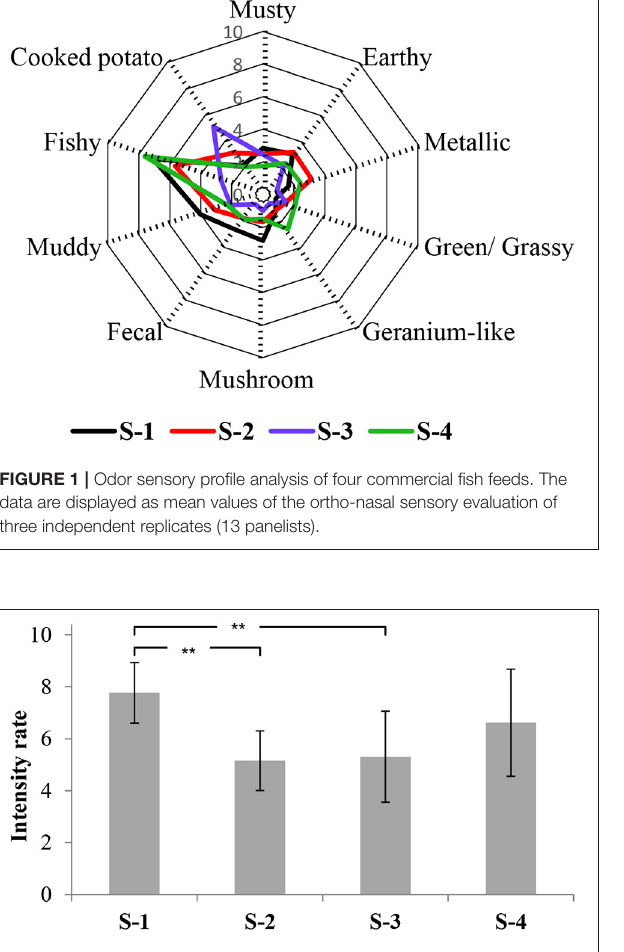
FIGURE 2 | Overall odor intensities of four commercial fish feeds. The data are displayed as mean values of the ortho-nasal sensory evaluation (13 panelists) of three independent replicates with their corresponding standard deviation and significance (** p <